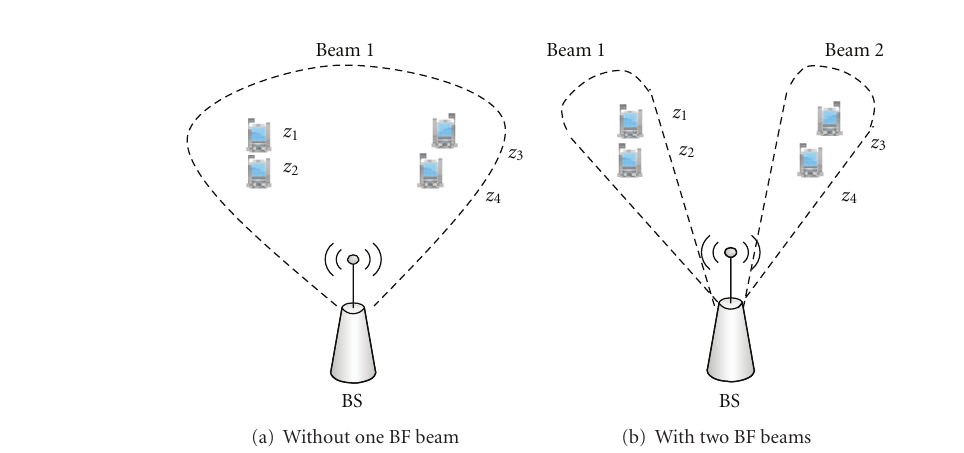
Figure 5: Example of MS